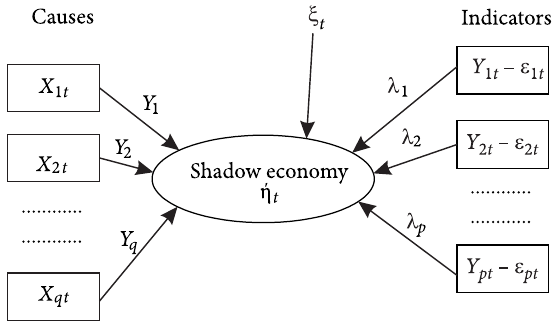
Figure 1. General structure of the MIMIC